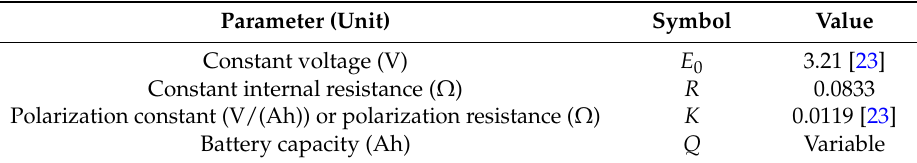
Table A1. Battery models